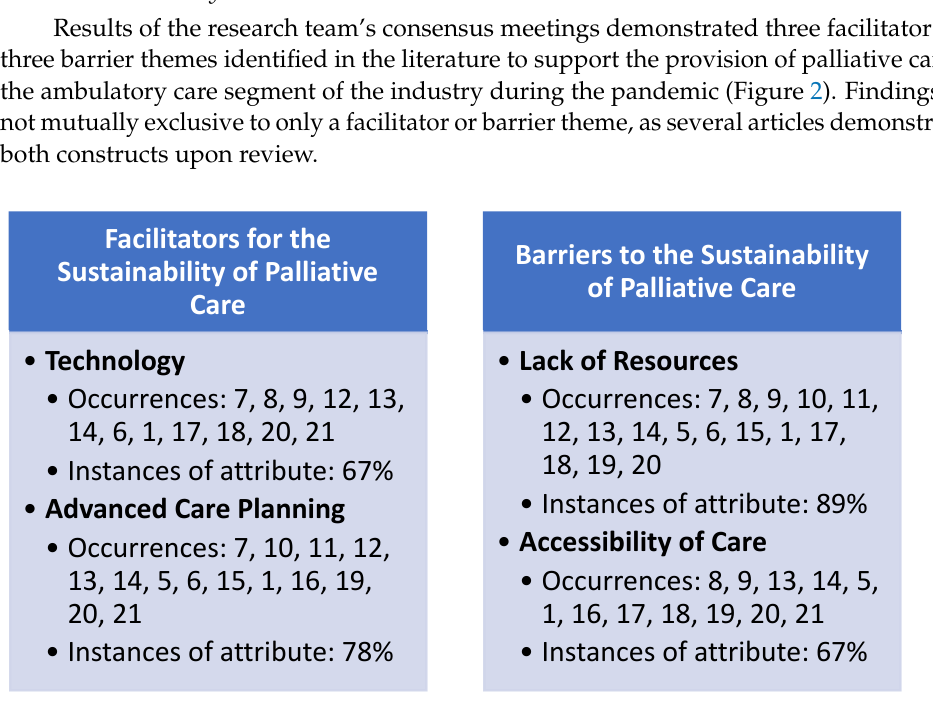
Figure 2. Identified themes (constructs) identified as facilitators and barriers for the sustainability of palliative care during the COVID-19 pandemic.